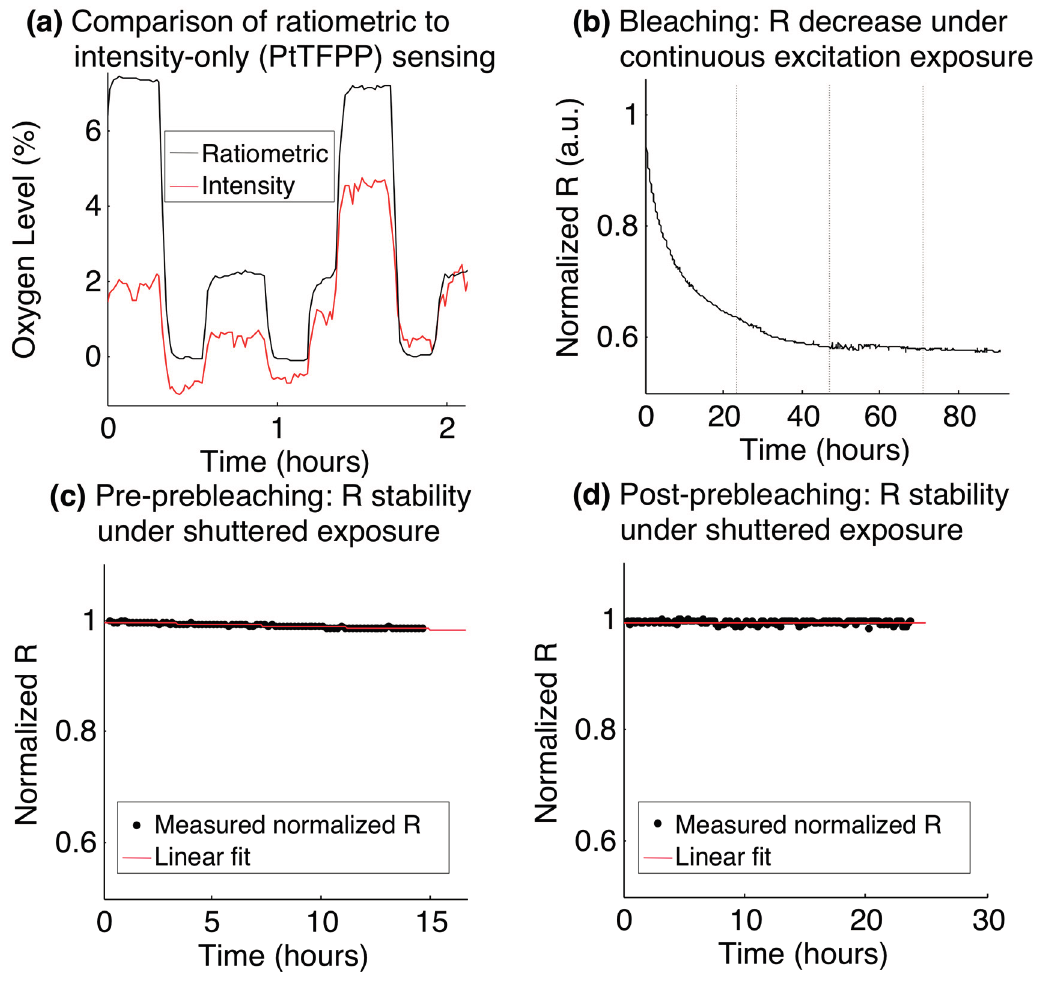
Figure 4. Stability of ratiometric sensors over time. ( a ) Comparison of ratiometric stability with the stability of the PtTFPP channel alone during a fluidic oxygen switching experiment; ( b ) Ratiometric intensity decrease over time while being constantly exposed to the fluorescence excitation source (dotted vertical lines denote increments of days); ( c ) Stability of the ratiometric intensity (black), before pre-bleaching. The standard deviation of the normalized ratiometric intensity over the 14.5 h time course was 0.0038, and a linear fit to the normalized ratiometric intensity (red) shows a slope of − 1.5 × 10 − 5 min − 1 ; ( d ) Stability of the ratiometric intensity (black), after a 61-h pre-bleaching process. The standard deviation of the normalized ratiometric intensity over the 23.5 h time course was 0.0035, and a linear fit to the normalized ratiometric intensity (red) shows a slope of − 1.4 × 10 − 6 min − 1